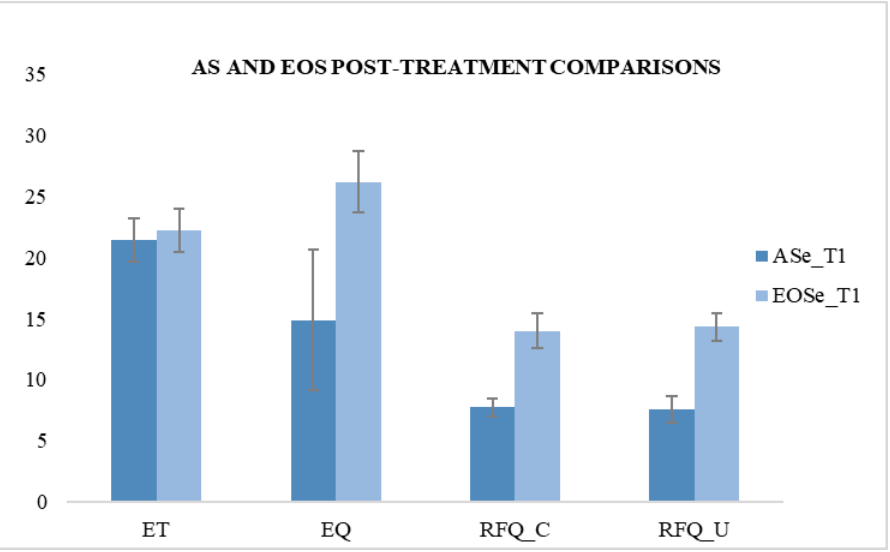
Figure 4. Comparison between ASe and EOSe at T1.